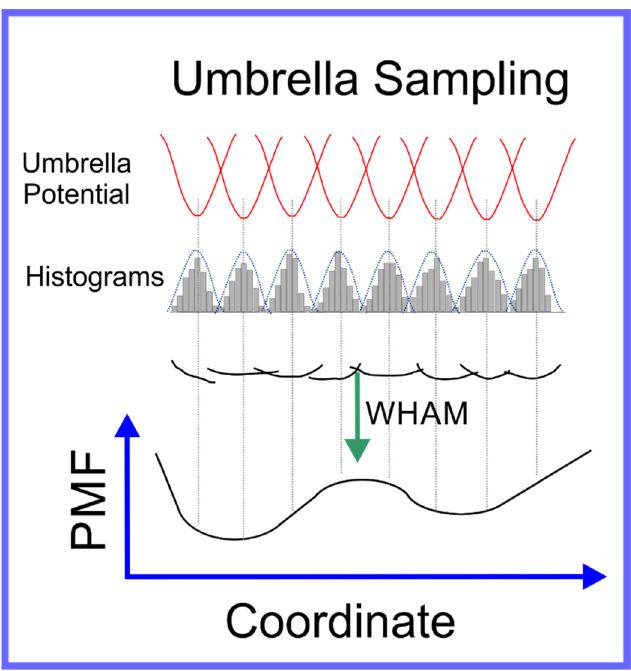
Figure 5. Schematic representation of umbrella sampling algorithm.